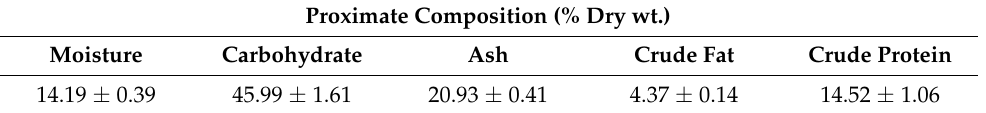
Table 1. Proximate composition of S. horneri . Proximate Composition (% Dry wt.)